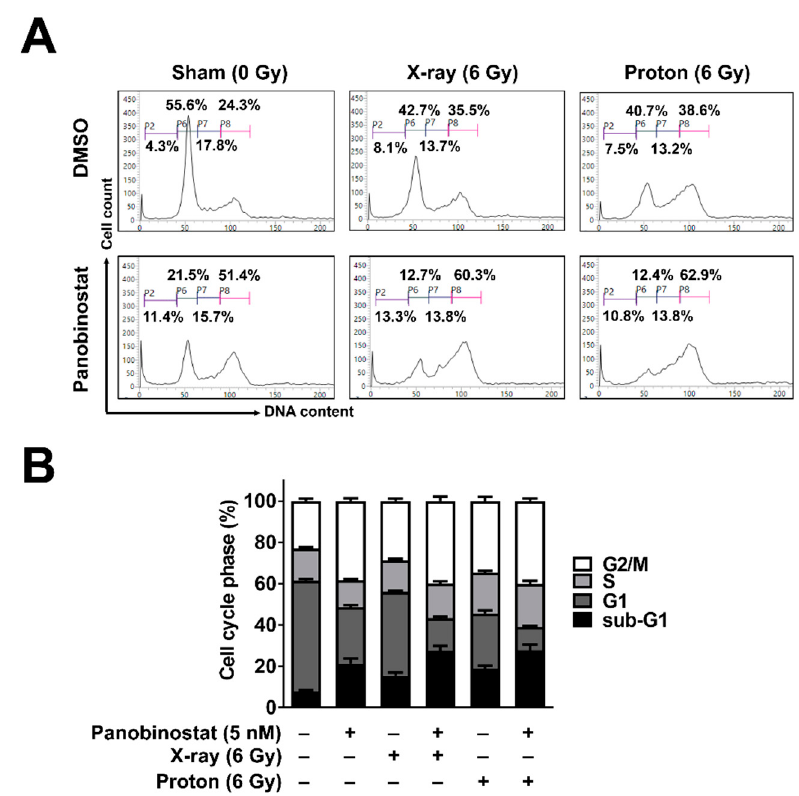
Figure 2. Effects of panobinostat combined with X-rays or protons on cell cycle progression in Huh7 cells. ( A ) Panobinostat induced G2/M arrest and increased the sub-G1 population when combined with radiation. Representative histograms were shown. Huh7 cells were pre-incubated with 5 nM panobinostat for 3 h and then irradiated with 6 Gy of X-rays or protons. At 24 h post-irradiation, cell cycle progression was analyzed using flow cytometry with propidium iodide staining. ( B ) Quantification of cell cycle phases. The data represent the mean ± S.D. (n = 3).